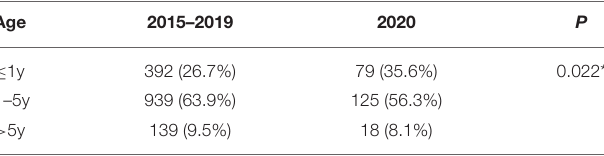
TABLE 5 | The comparision between different